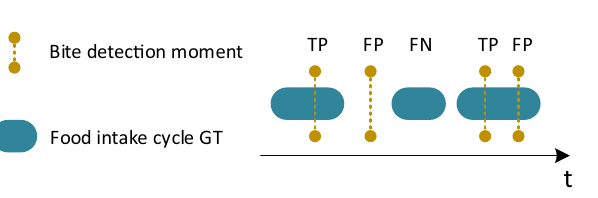
Figure 5. Representative examples of the evaluation scheme 47 that was used to produce the results in EXI. The first bite within a GT interval counts as a True Positive (TP), any further detected bites count as False Positives (FP). In addition, detected bites outside GT intervals also count as FP. Empty GT intervals without any detected bites count as False Negatives (FN). It should be noted that the adopted evaluation method cannot calculate the number of True Negatives (TN).